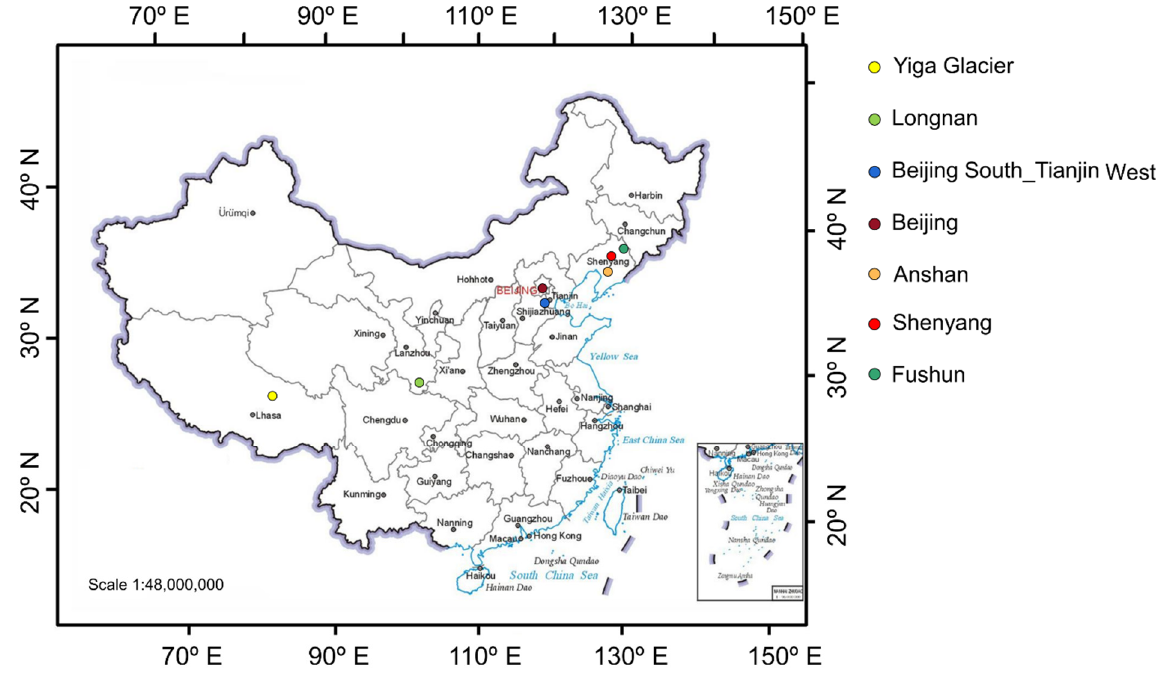
Figure 1. Location of the areas of interest used in the Dragon 4 project.